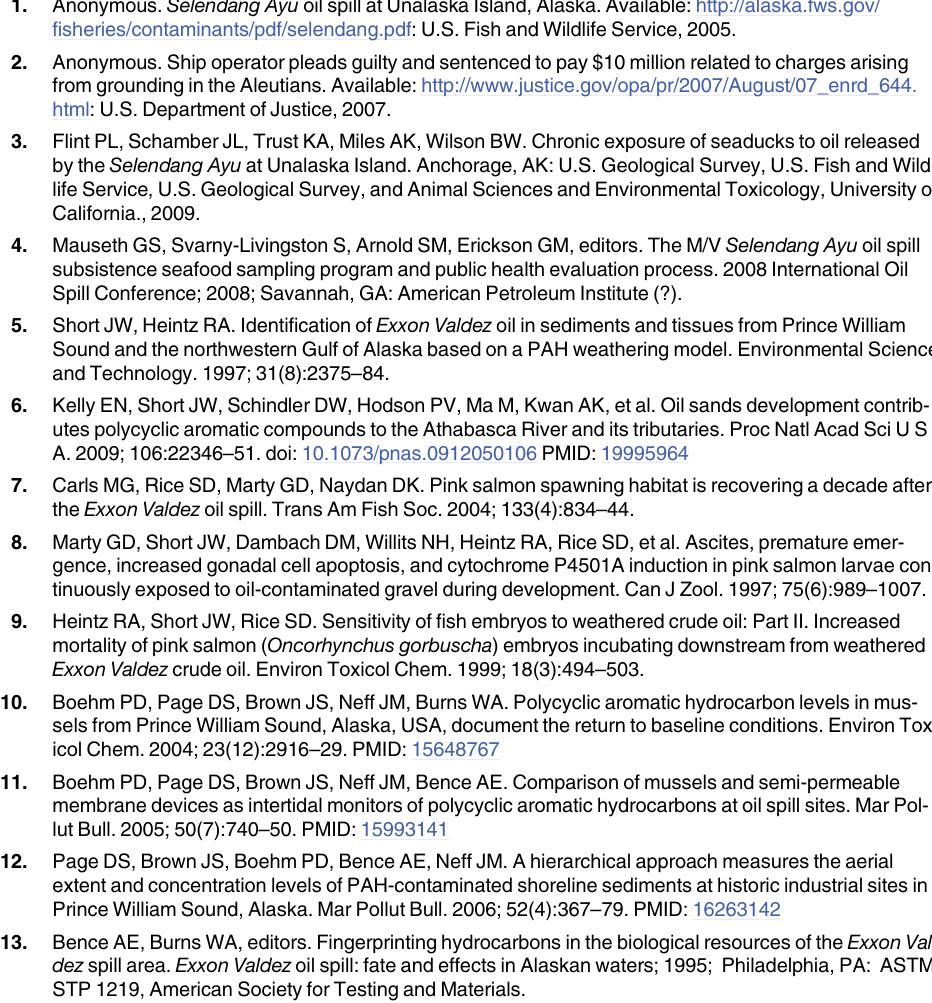
S6 Table. Attributes of source oils; intermediate fuel oil heavy (IFO light (IFO ), and marine diesel oil L